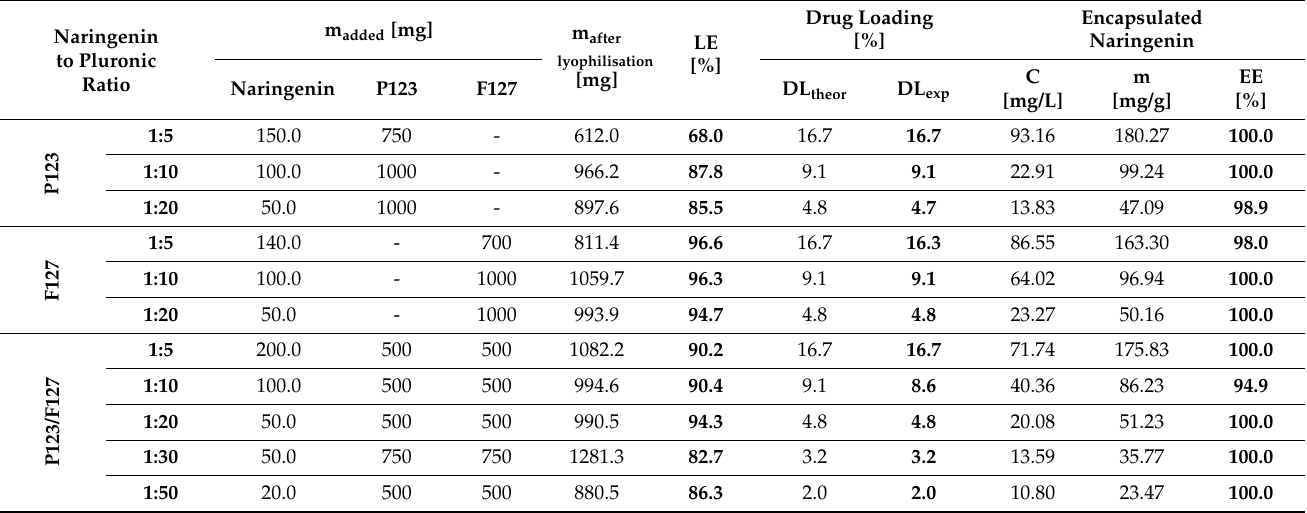
Table 1. Results of naringenin ‐ loaded micellar nanoparticles preparation. LE—lyophilisation effi ‐ ciency, DL theor —theoretical drug loading, DL exp —experimental drug loading, EE—encapsulation ef ‐ ficiency.